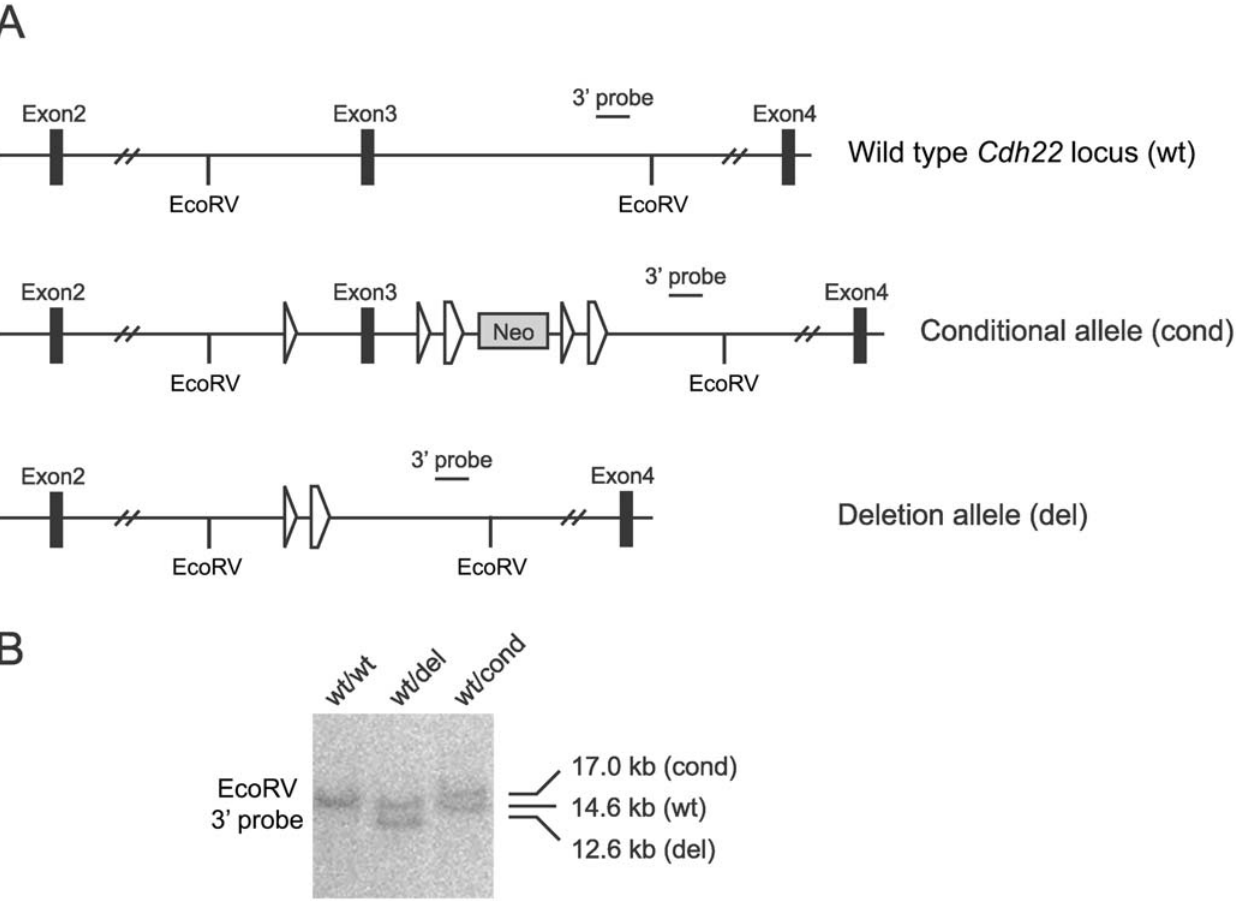
Figure 7. Comparison of wild type, conditional, and deletion alleles of the mouse Cdh22 locus. ( A ) A schematic of wild-type (wt), conditional (cond), and Cre-recombined (del) Cdh22 alleles. ( B ) Southern blot analysis of DNA isolated from the tails of mice carrying different Cdh22 alleles (EcoRV digestion), with the 3 9 probe illustrating the 14.6 kb wild type (wt), 17.0 kb conditional (cond), and 12.6 kb deletion (del) alleles.